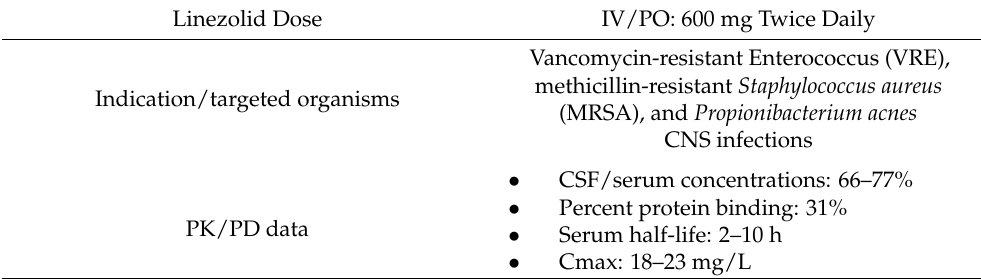
Table 3. Linezolid dosing and PK/PD data.